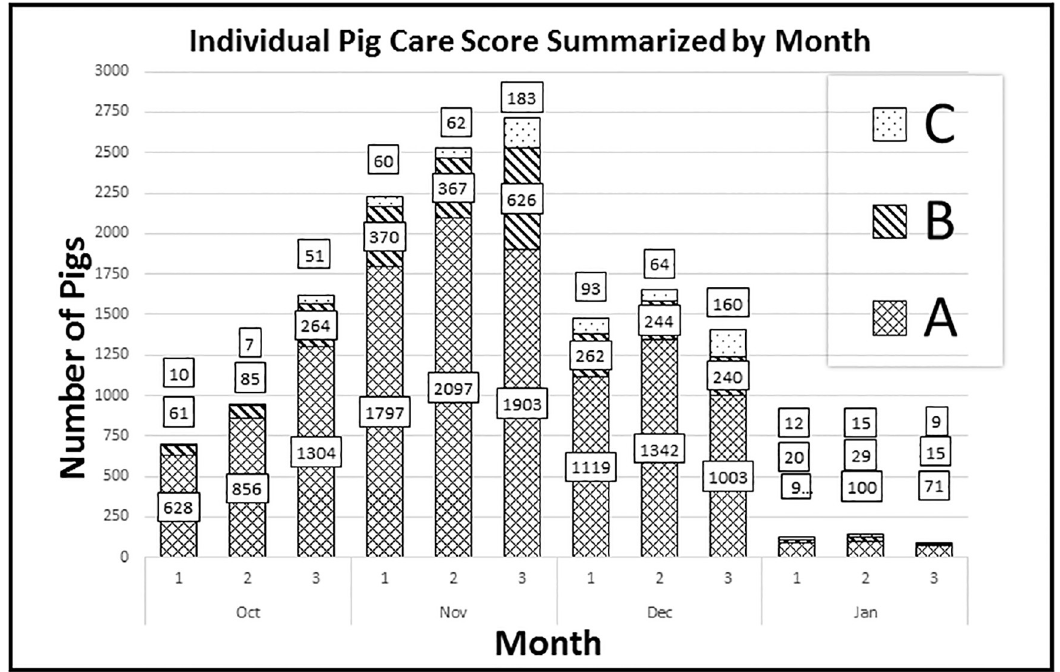
Fig 2. Individual Pig Care (IPC) scores for treatment groups T1, T2, and T3 during the four months from weaning to finish. The three numerical values adjacent to each bar indicate, in descending order, the IPC scores for categories A (mild clinical disease), B (moderate clinical disease), and C (severe clinical disease). IPC scores spiked immediately after PRRSV challenge (C arrow) and declined when ABF restrictions were lifted and group medication was initiated (M arrow) for all groups, including the antibiotic-free group T3 as an animal-health intervention. The standard medication group T1 had the lowest cumulative IPC scores before PRRSV challenge and during the month following challenge, indicating that this group had the lowest level of clinical disease, followed successively by the T2 and T3 groups.